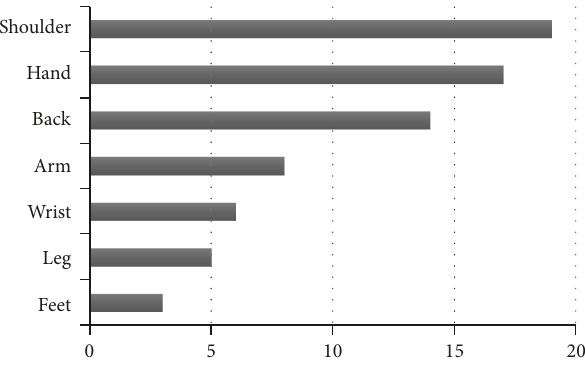
Figure 1: Part of body selected for massage in distance communica- tion (N=50, multiple choice